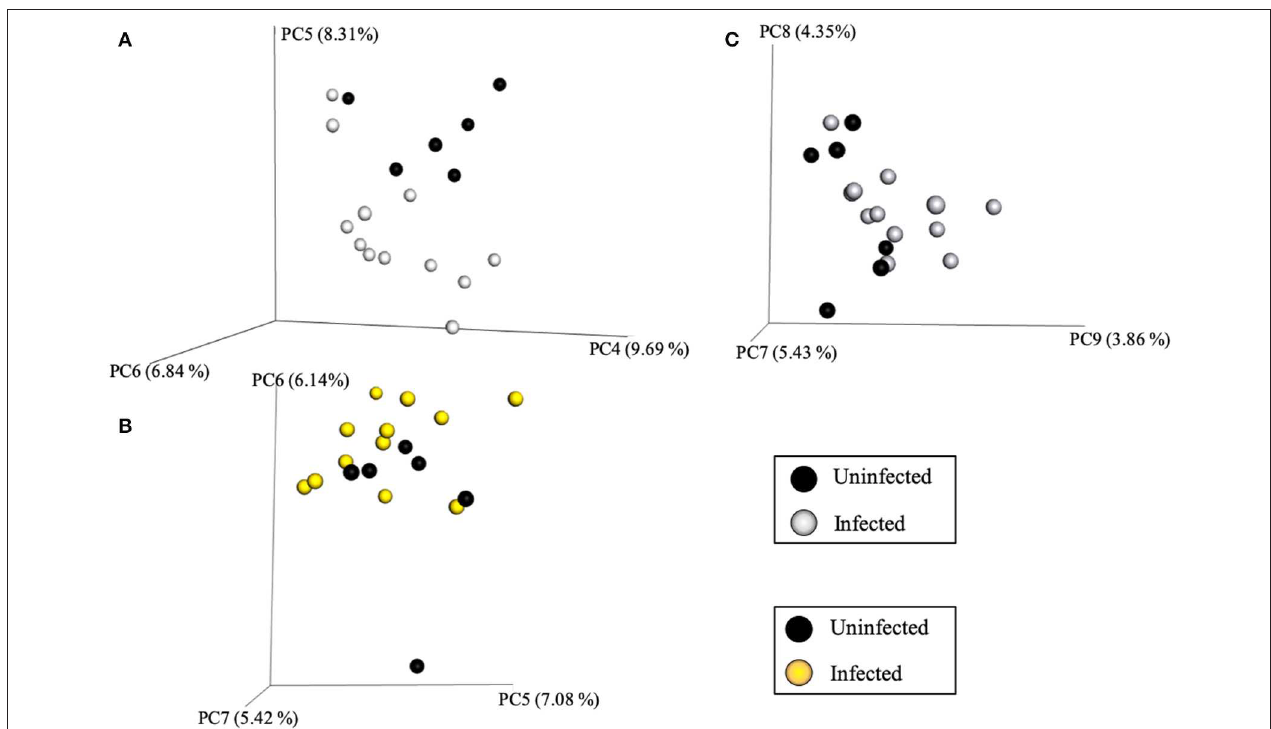
FIGURE 7 | Bray Curtis PCoA plot of beta diversity measures of dissimilarity shows, when the data sets were sorted by infection status, they clustered within their groups along PC5 at the species level (A) , PC6 at the genus level (B) , and PC9 at the family level (C) .